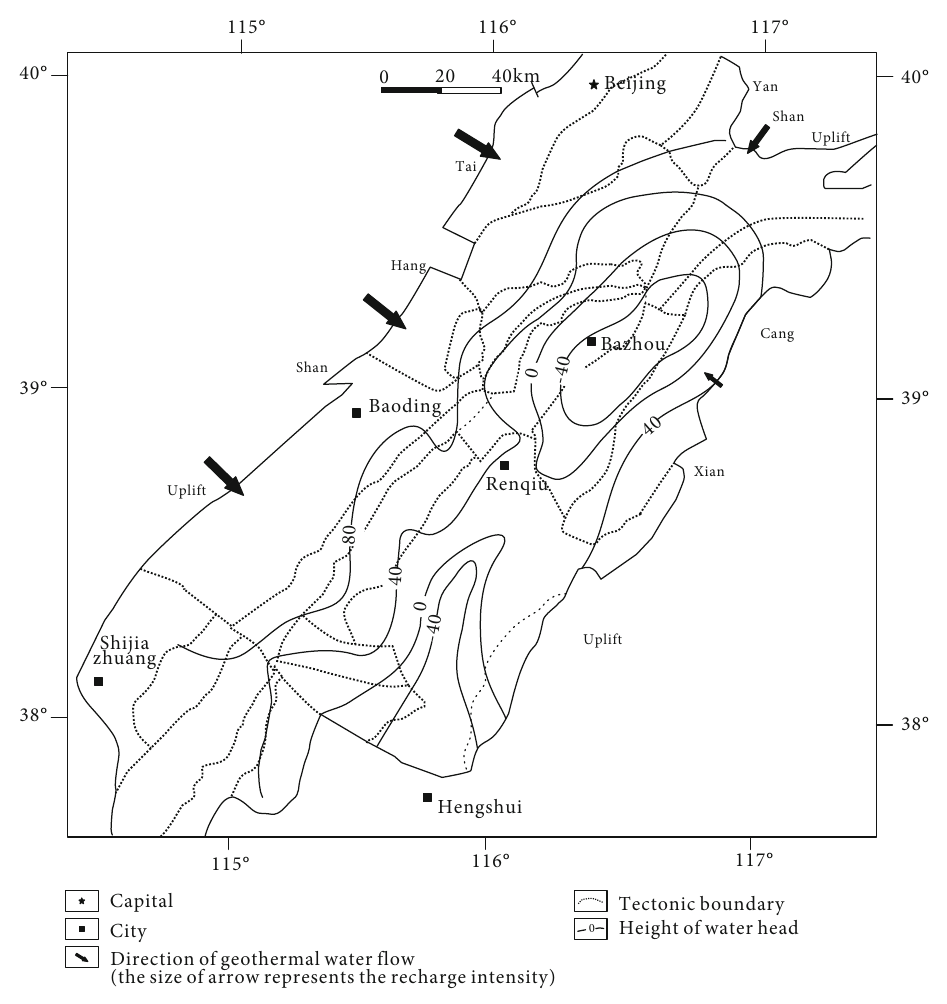
Figure 3: Current water head distribution of the geothermal reservoir in the buried hill of the study area.